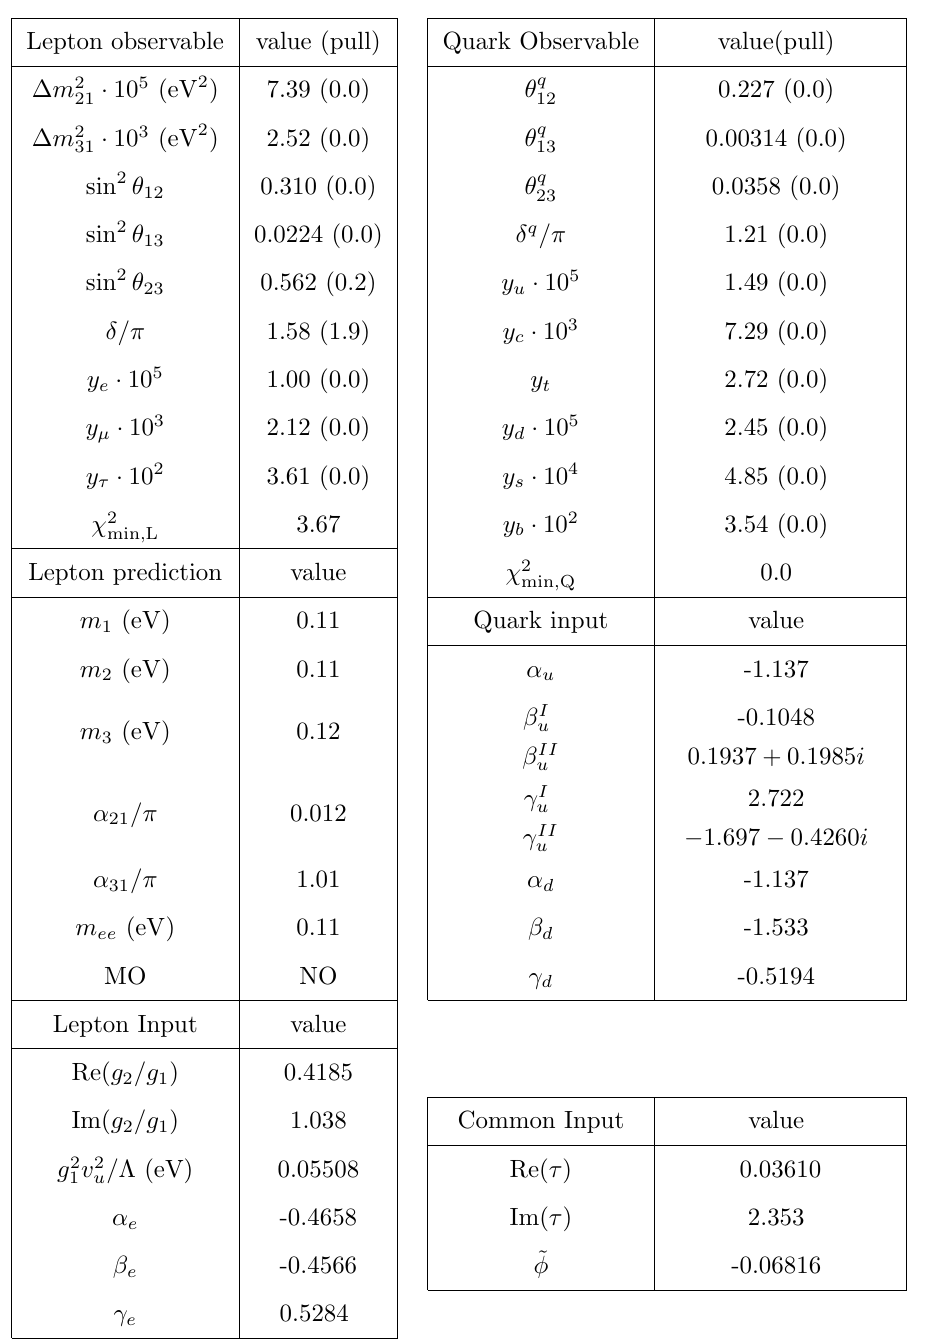
; Y II . u d contribution min,L quark contribution, and quark inputs. min,Q